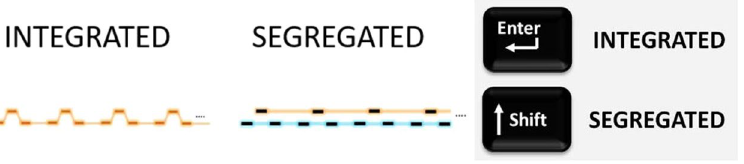
Figure 6. Mnemonics for the perceptual interpretations of the tone sequence; INTEGRATED, SEGREGATED, and the key